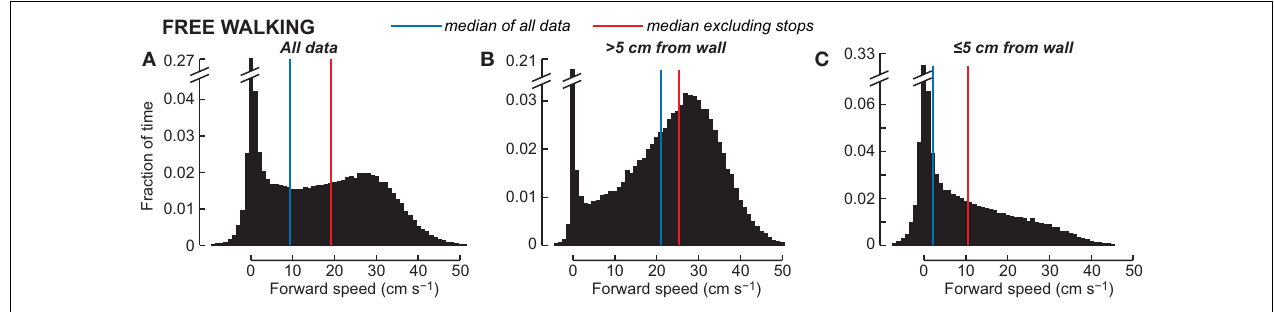
was less than 5cm from the nearest wall [ (A,B) ; n = 28,464 samples].The blue vertical lines indicate the median walking speed in each histogram; the red lines show the median speed when data with an absolute value less than 1cm/s are excluded. From Bender et al.